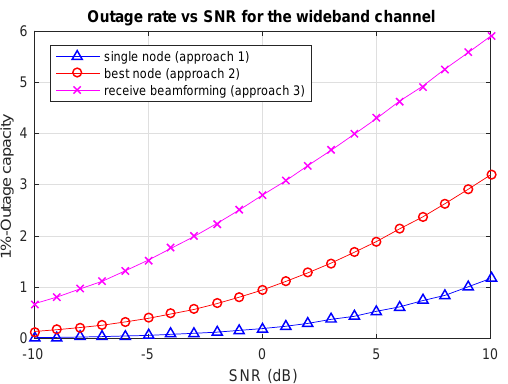
Figure 11. 1% outage rates vs. per node SNR for wideband channels using 10% of the 20 MHz uplink bandwidth with single node, best node and ideal receive beamforming with using N = 10